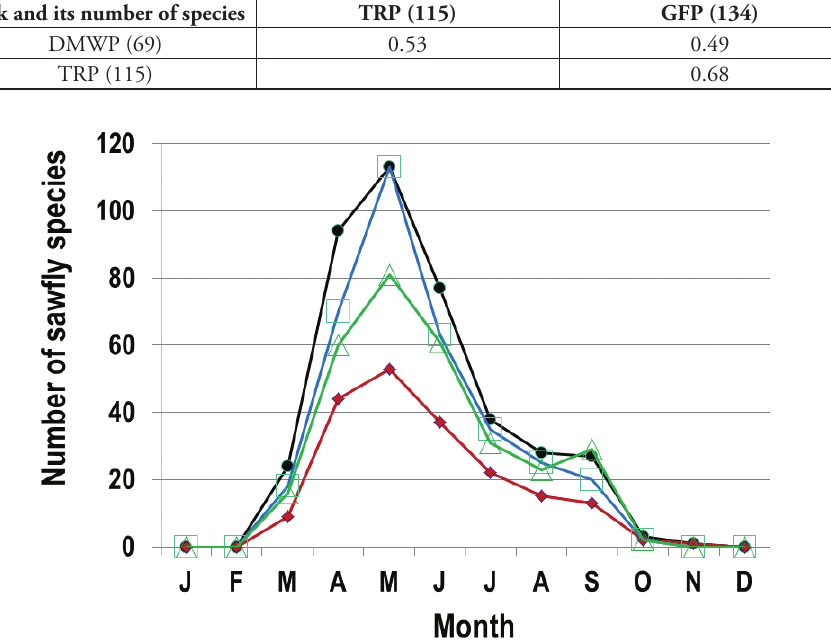
Figure 2. Number of sawfly species versus month in the GWMP, Virginia. Diamonds represent sawfly numbers in DMWP; squares, GFP; triangles, TRP; and circles, all three parks